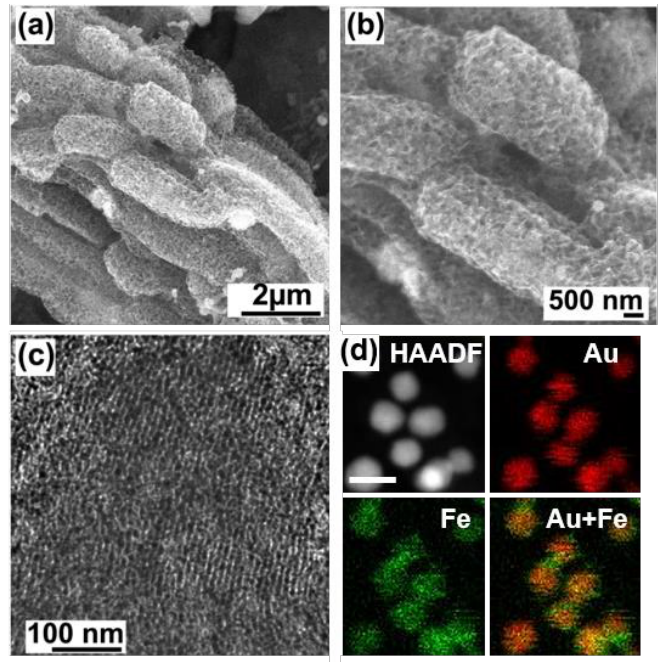
Figure 3. ( a ) Scanning electron microscope (SEM); and ( b ) transmission electron microscope (TEM) images of the nanoporous Au-Fe ( c ). An annular-dark field (HAADF) image and compositional mapping images of the nanoporous Au-Fe corresponding to Au, Fe, and a merged image ( d ). The scale bar in ( d ) corresponds to 10 nm.